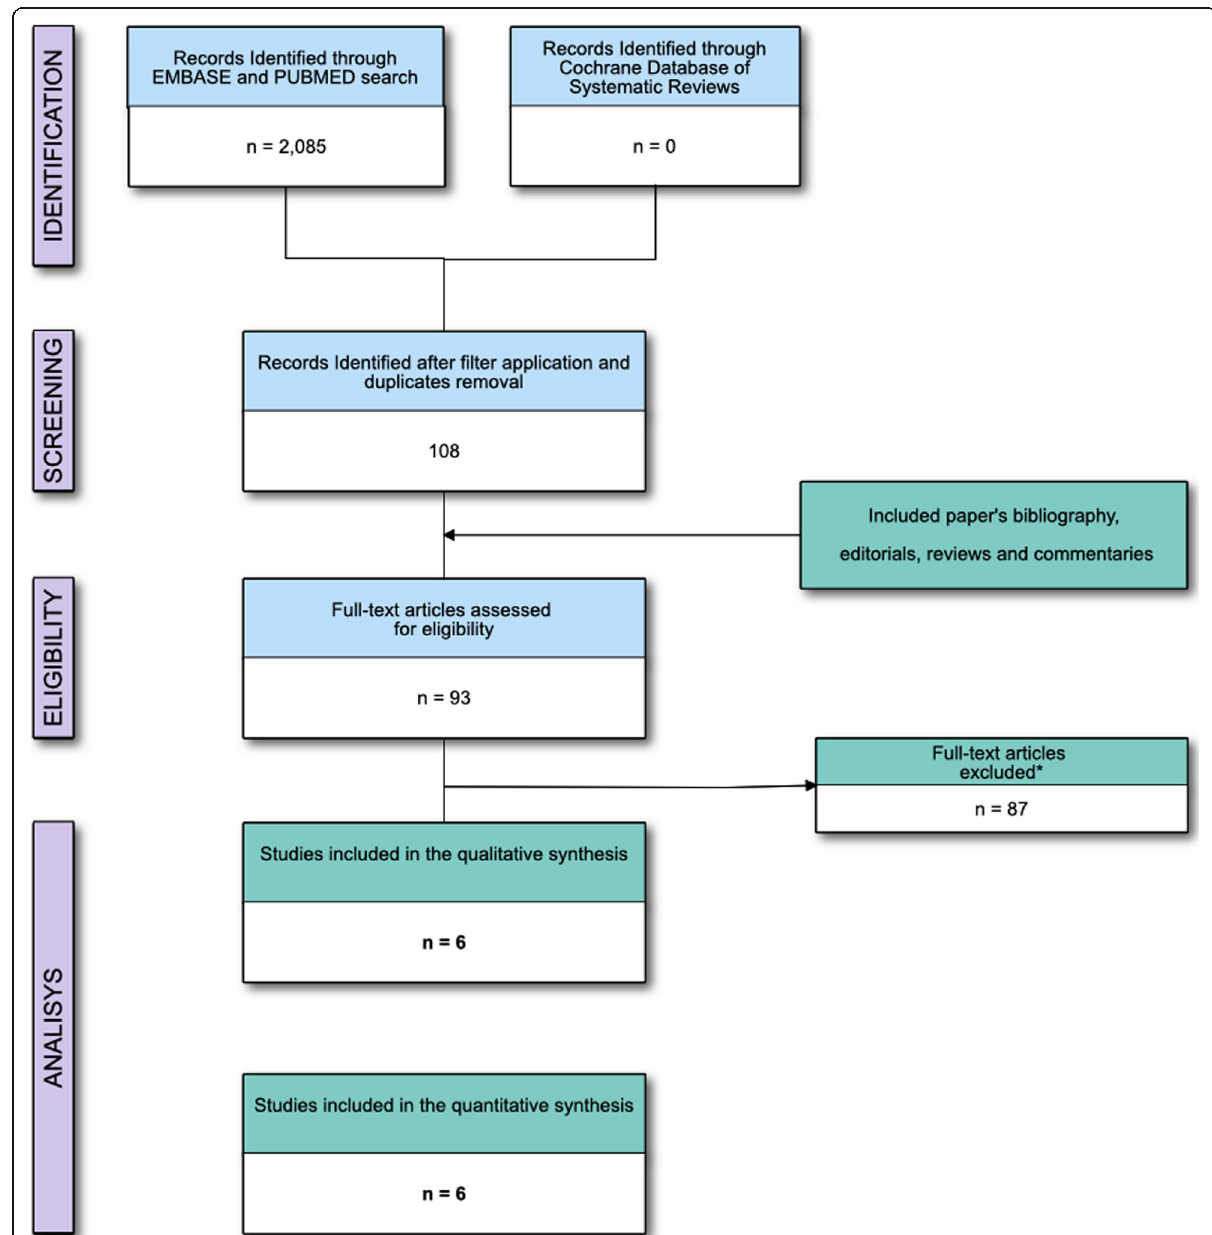
Fig. 1 Flow of the studies. *Excluded studies are reported in Supplemental Table 4 in the Online Supplemental